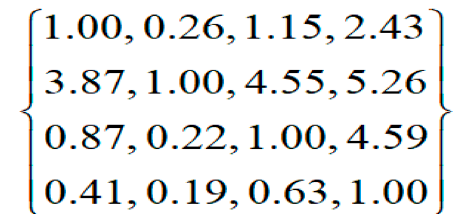
Figure 3. Judgment matrix.